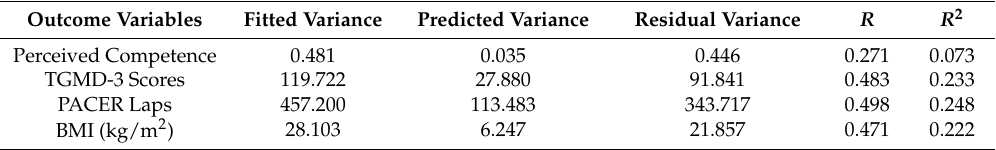
TGMD-3 stands for the Test of Gross Motor Development-3rd Edition; PACER stands for the Progressive Aerobic Cardiovascular Endurance Run; BMI stands for Body Mass Index; R is the multiple correlation coefficient; R 2 is the coefficient of